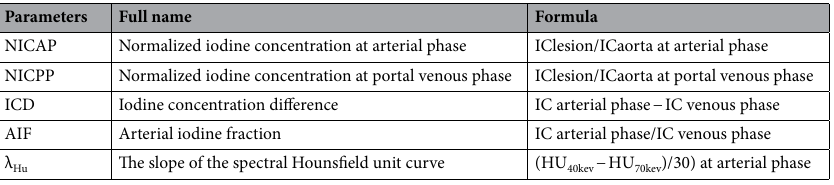
Table 1. Calculation formula of each